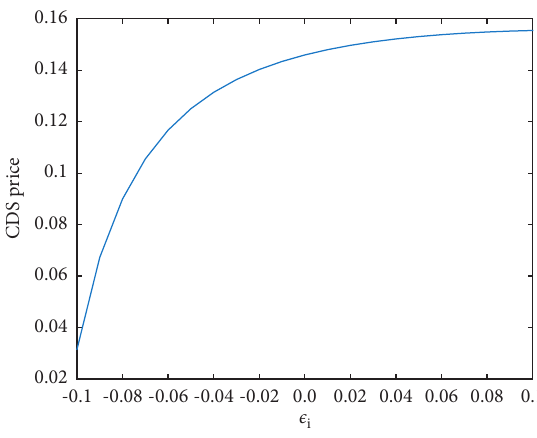
Figure 9: The CDS prices under different λ